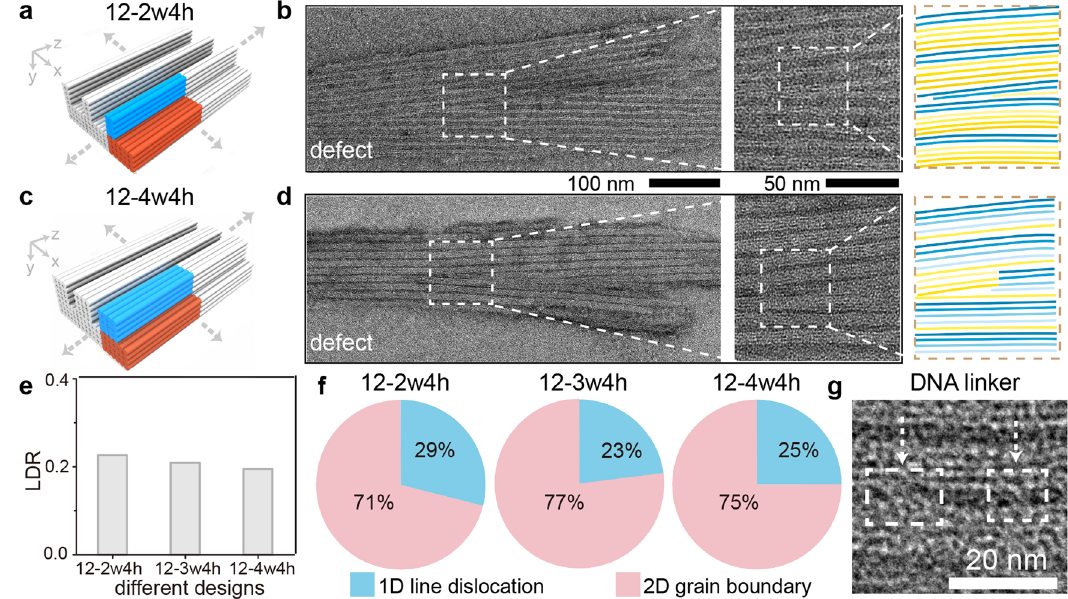
Fig. 3 Crystallographic defects for different line designs. Design schematic ( a and c ), zoomed-out (left), zoomed-in (center) TEM images, and the line schematics (right) along the x – z projection plane ( b and d ) for the representative pattern defects of DNA line arrays (12-2w4h in a and b and 12-4w4h in c and d ). The scale bars are 100 nm (left) and 50 nm (center). LDR values ( e ) and the compositions of the high-dimensional crystallographic defects ( f ) for DNA lines arrays of 12-2w4h, 12-3w4h, and 12-4w4h. g Intermediate DNA linkers (indicated by the white arrows) between parallel DNA lines, indicating defect penetration is blocked by correct lattices nearby. The scale bar is 20